Question: Write a single sentence explaining what this figure depicts.
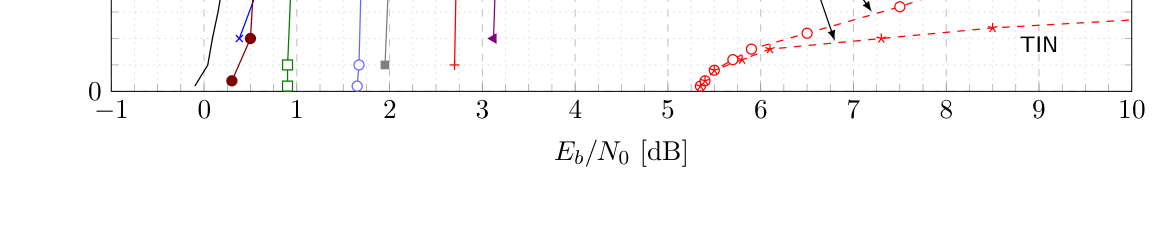
Answer: reports the performance of 2SRA over the Gaussian MAC. The performance is provided in terms of minimum SNR required to achieve a target per-user probability of error (PUPE) of 5 × 10−2. On the same chart the performance of several UMAC schemes from the literature is shown, together with the UMAC achievability random coding union (RCU) bound of [4] ( ). The bound as well as the competing schemes assume 30000 real c.u.s. The schemes for which the performance is provided are T-fold irregular repetition slotted Aloha (IRSA) [5] ( ), sparse IDMA [6] ( ), coded compressed sensing (CCS) [7] ( ), the CCS sparse regression code (SPARC)-based construction of [8] ( ), and the spread-spectrum scheme with data-dependent spreading codes from [9] ( ).